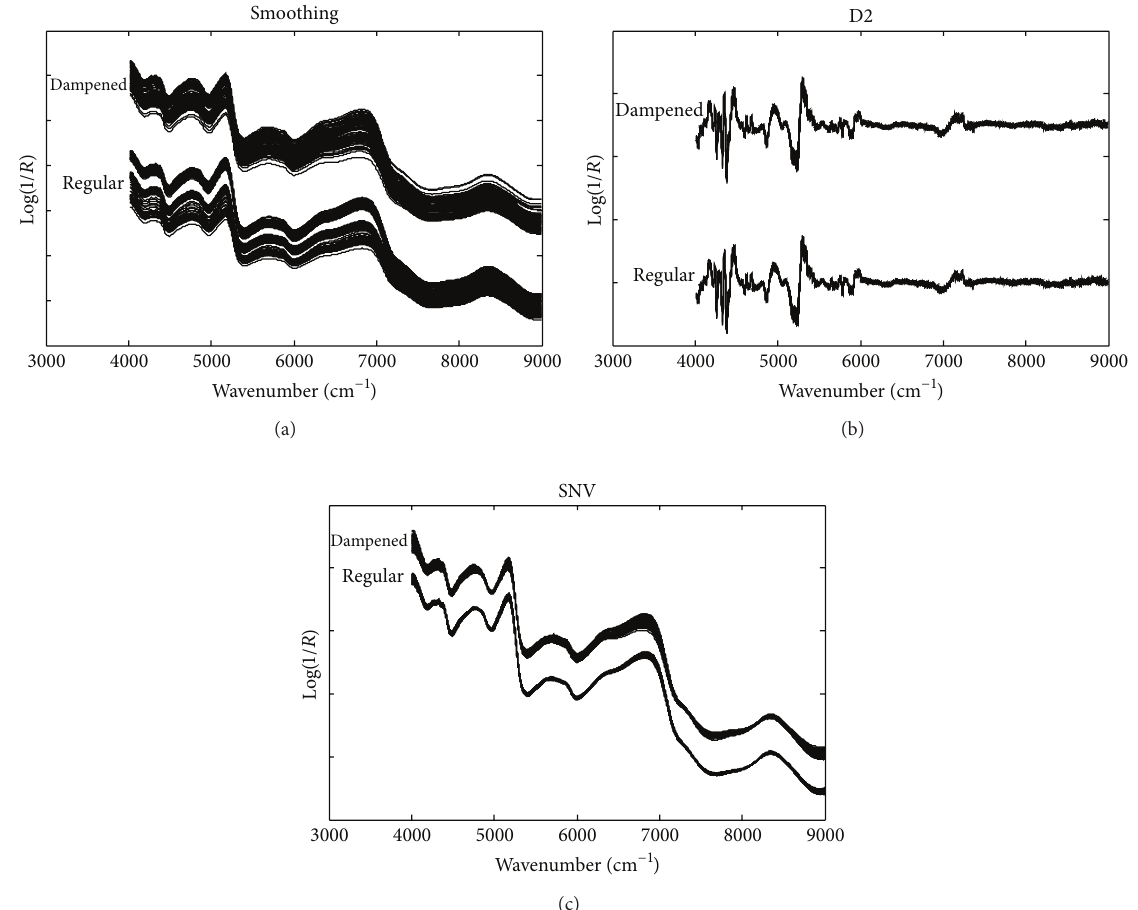
Figure 2: The NIR spectra of regular and dampened WLS preprocessed by smoothing, taking second-order derivatives (D2) and standard normal variate (SNV).